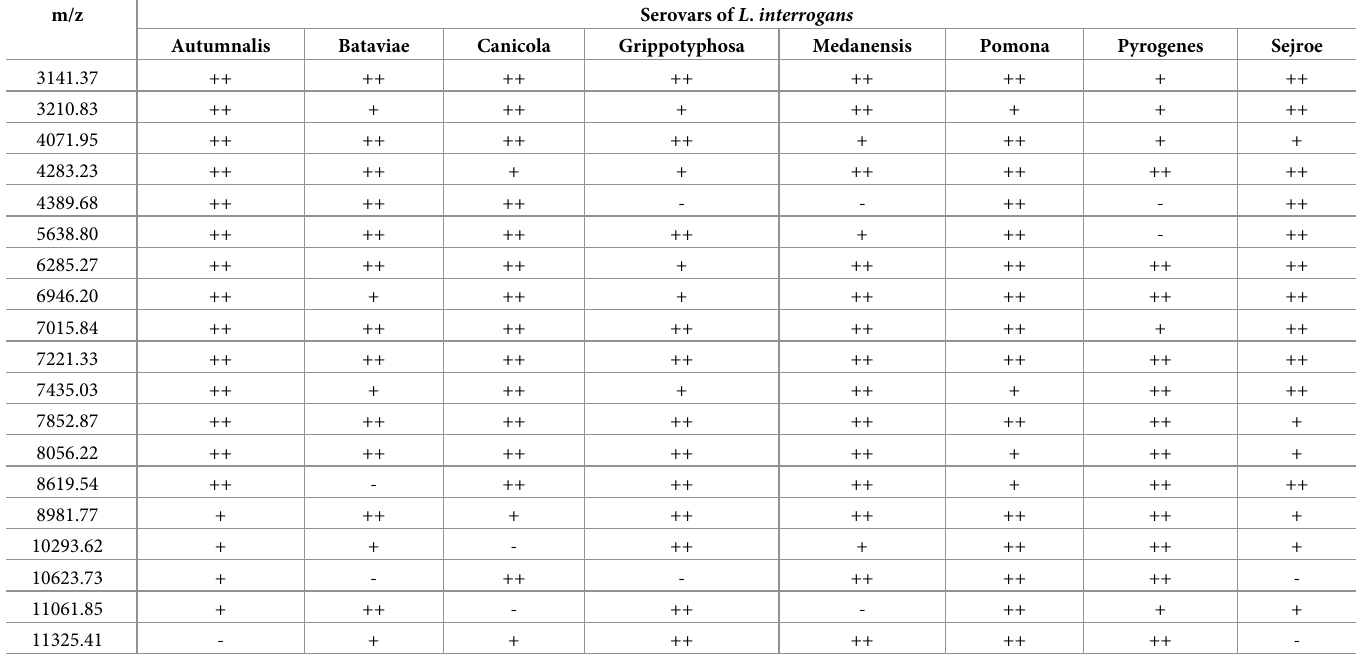
Table 8. Peaks for differentiating among 8 serovars of L . interrogans .